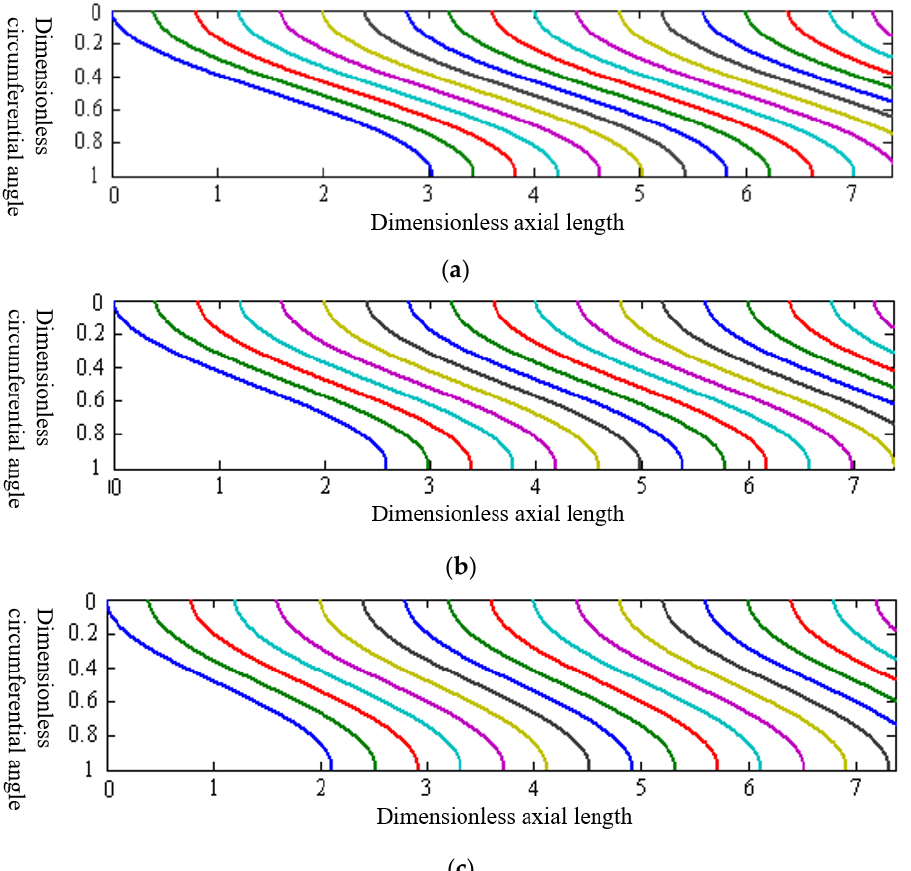
Figure 5. Solution result of theoretical mode in different deviated angles. ( a ) well deviation angle = 85°; ( b ) well deviation angle = 83°; ( c ) well deviation angle = 80°.